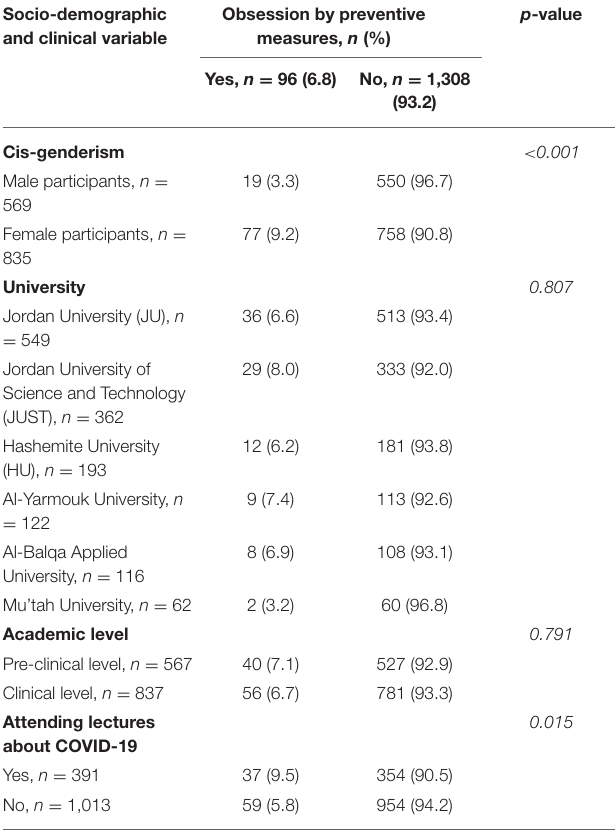
such lectures (5.8%), with an unadjusted OR of 1.69 (95%